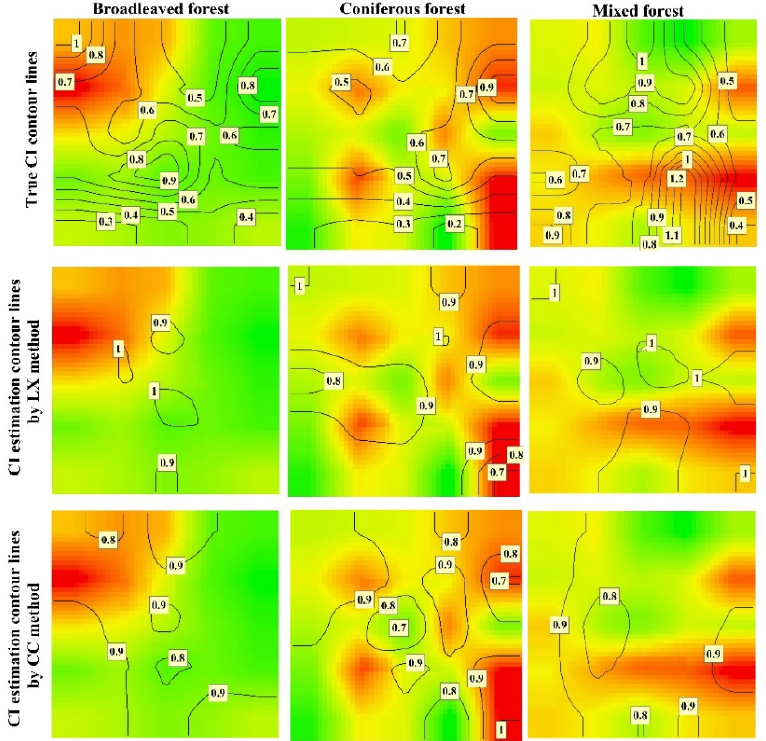
Figure 7. Distribution of the trees and their density in the plots.